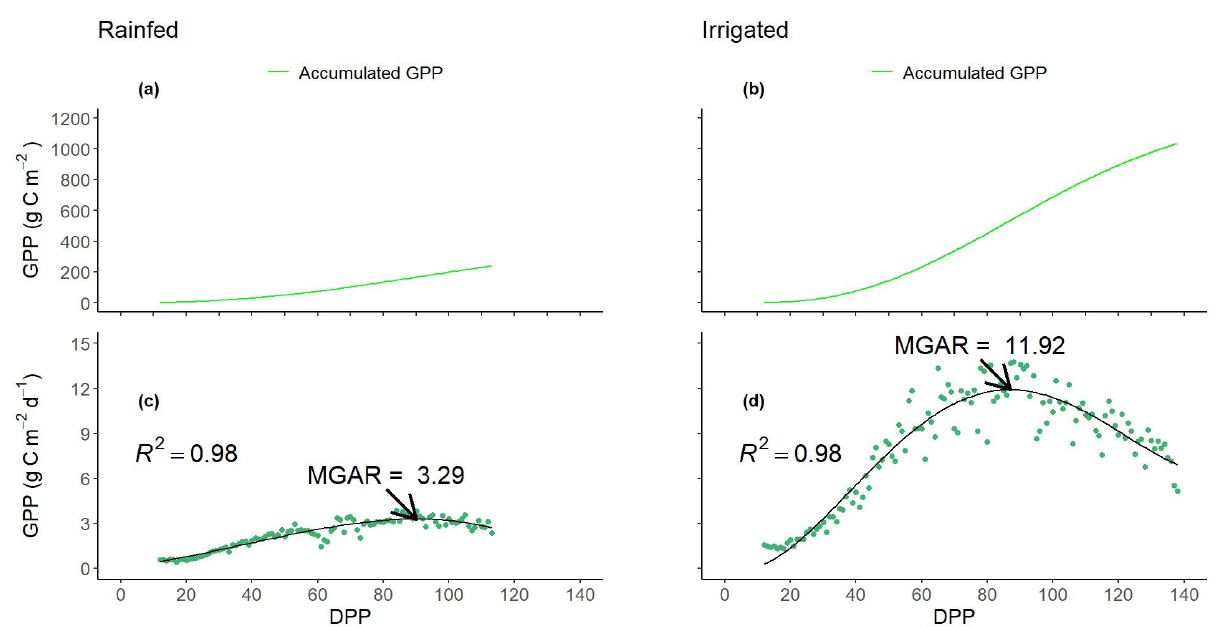
Figure 3. Accumulated and daily gross primary productivity (GPP) in ( a ) Rainfed and ( b ) Irrigated, and maximum GPP accumulation rate (MGAR) in ( c ) Rainfed, and ( d ) Irrigated potato crop. The black arrow indicates the point of MAGR (maximum GPP accumulation rate).